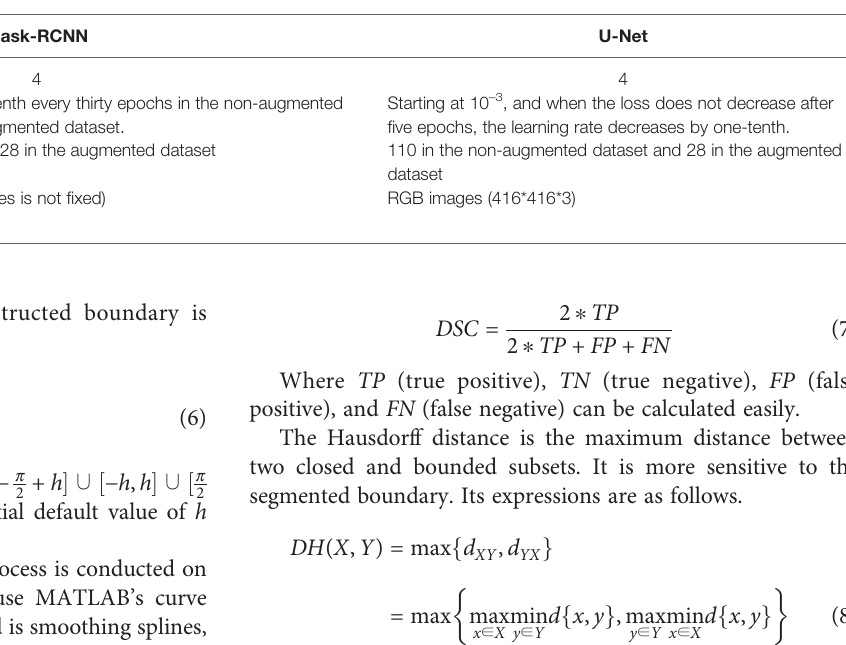
TABLE 2 | Parameters of the deep learning